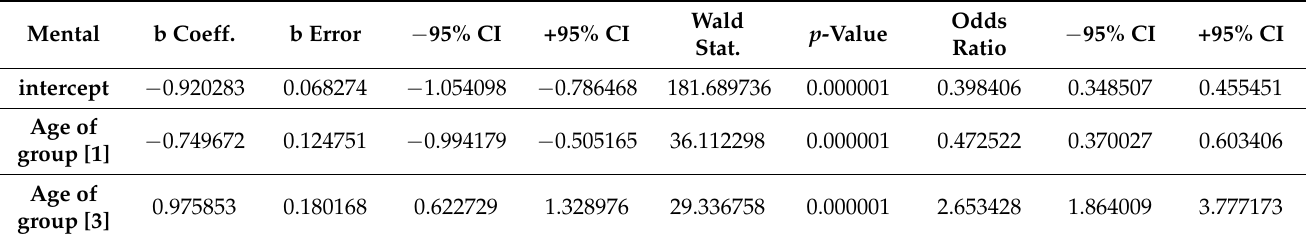
Table 8. Logistic regression model for psychological (emotional) symptoms of fear and three age groups.